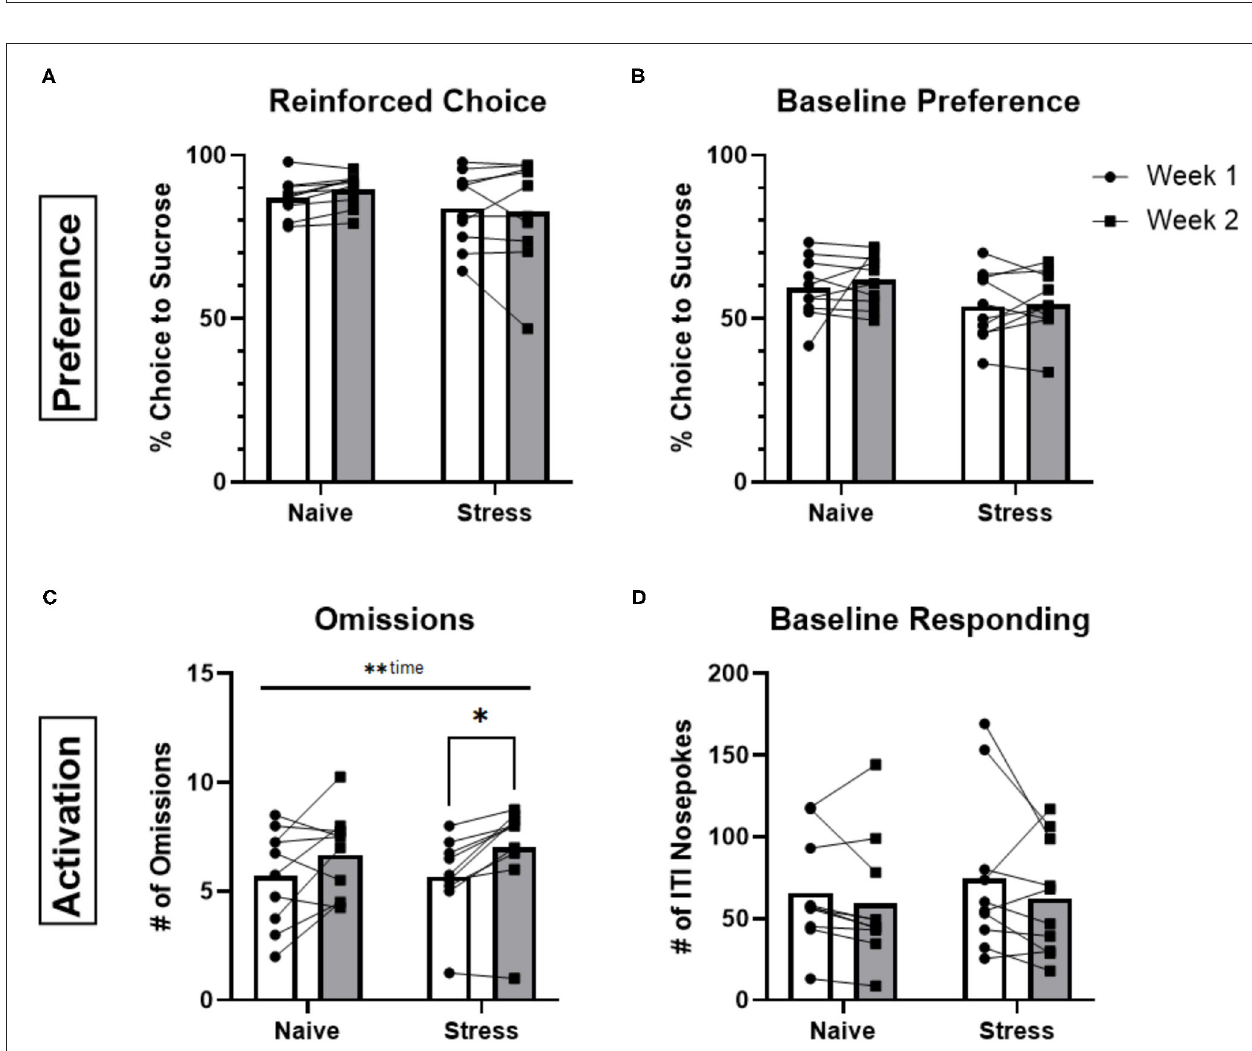
FIGURE 3 | Stress vs. stress-naïve behaviors. (A) Averaged percentage of reinforced choice for the sucrose liquid receptacle in free-choice trials for animals in sessions before (week 1) and after (week 2) the rFSS ( n = 10) or 2 rest days ( n = 10). (B) Percentage of ITI nosepokes made during the session for the sucrose liquid receptacle compared to water receptacle nosepokes during the ITI. (C) Total number of omissions made during the sessions. (D) Total number of ITI nosepokes made at all during the sessions. Error bars are ( ± SEM). * P < 0.05, ** P <